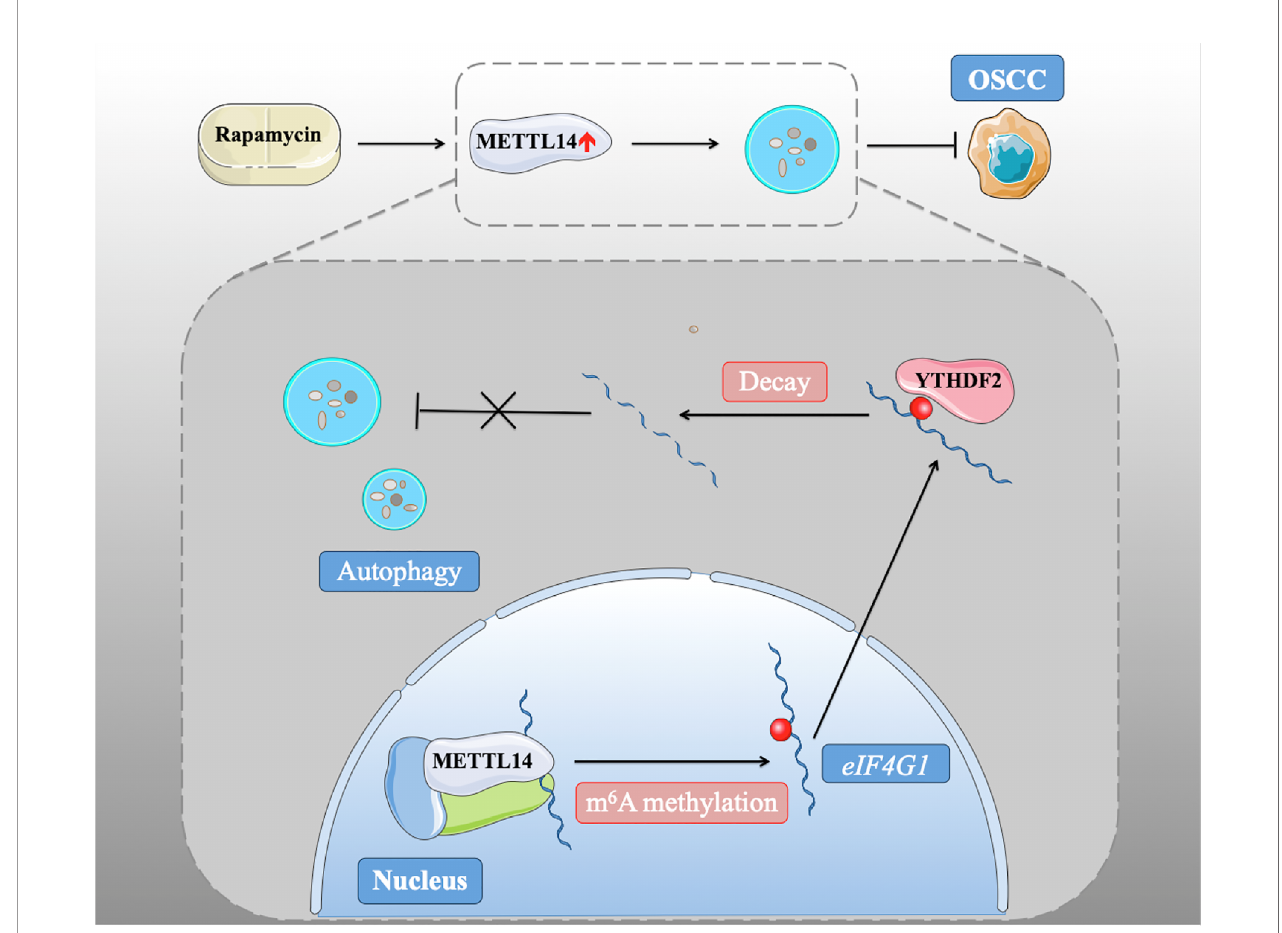
FIGURE 6 | METTL14 down-regulated eIF4G1 mRNA stability in a YTHDF2-mediated m 6 A